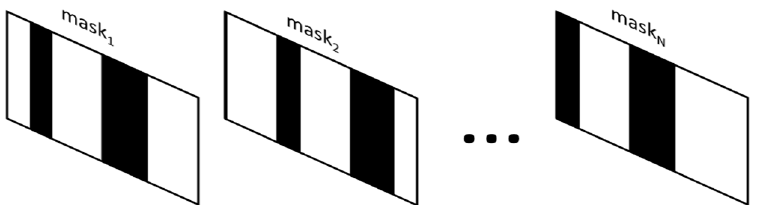
Figure 5. The sketch map of Hadamard multiple-stripe mode: in Hadamard multiple-stripe mode, multiple columns of micro-mirrors are turned on, corresponding to the Hadamard encoding matrix. The first detected light signal is reflected by mask 1 . Accordingly, the second detected light signal is reflected by mask 2 , and so on. After the last detected signal is detected with the reflecting of mask N , the raw data of the spectrum are acquired. By decoding with the computer, the spectra can be derived.